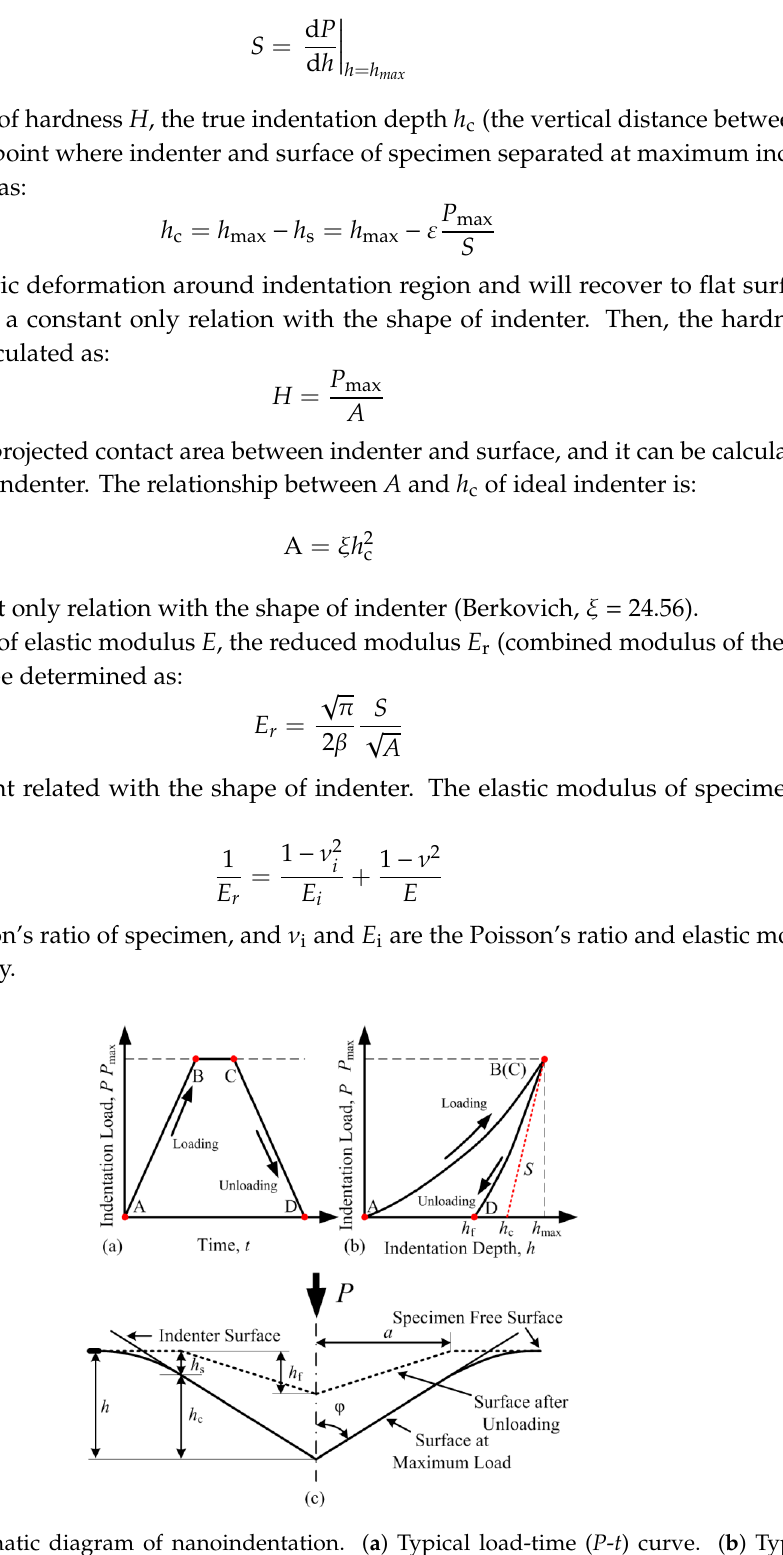
Figure 5. Schematic diagram of nanoindentation. ( a ) Typical load-time (P-t) curve. ( b ) Typical load-displacement ( P-h ) curve. ( c ) Physical meaning of parameters in calculation process.